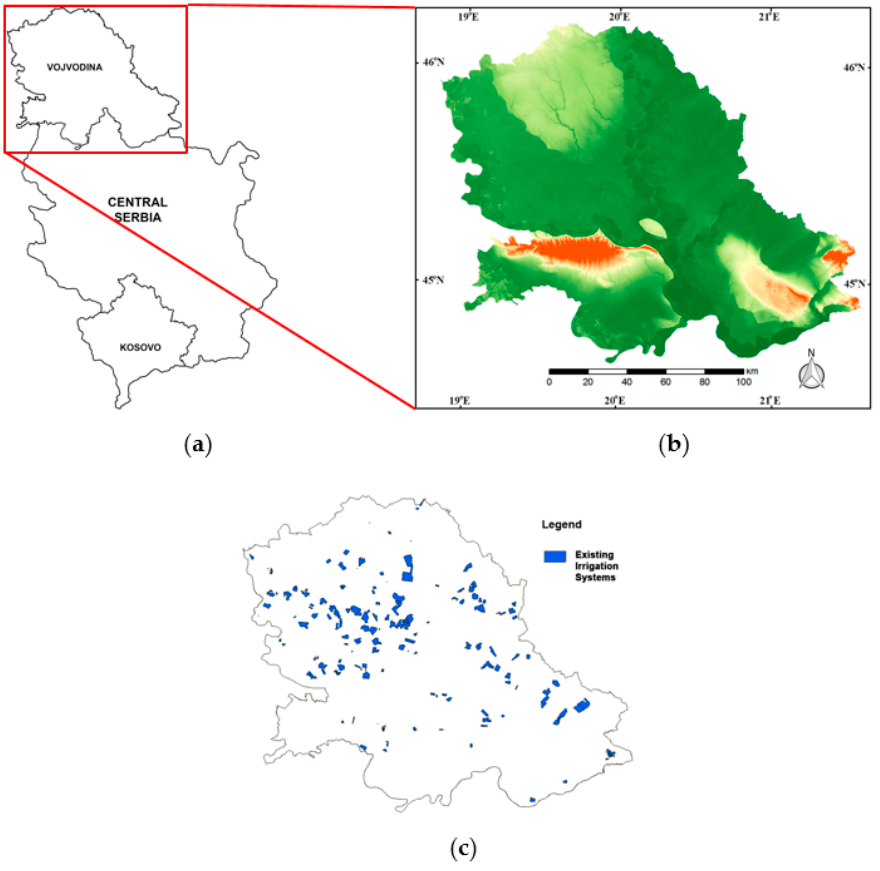
Figure 1. Map of the Republic of Serbia ( a ) and Vojvodina Province ( b ), with existing irrigation systems ( c